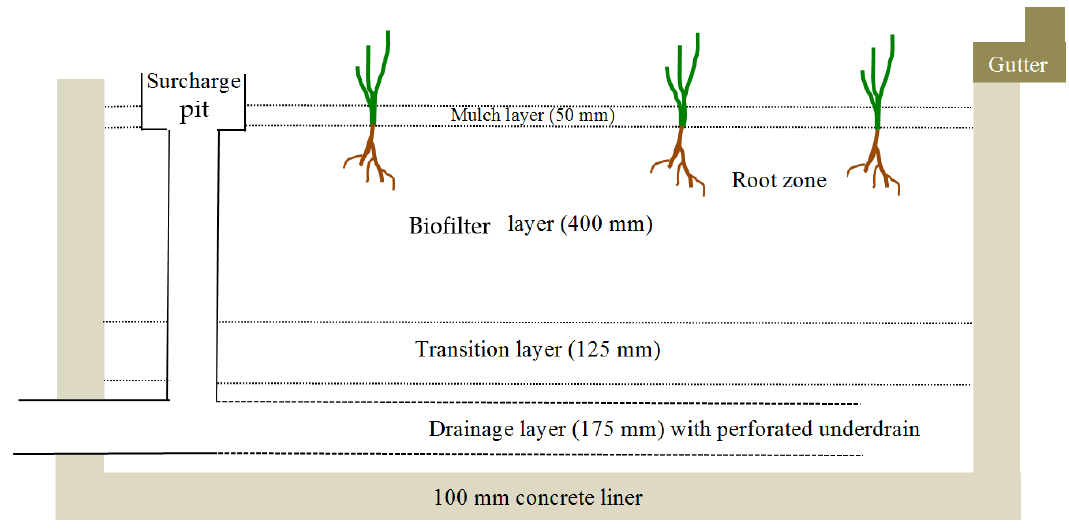
Figure 1. Schematic of a basic lined, monophasic field design showing filter layer depths.